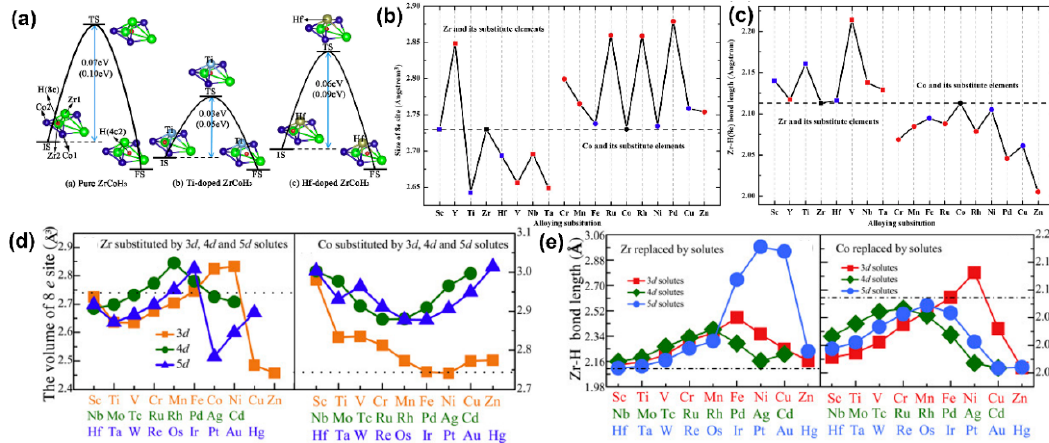
Figure 5. ( a ) Schematic diagram of H diffusion from the 8e site to the 4c 2 site in undoped, Ti-doped, and Hf-doped ZrCoH 3 ; ( b ) sizes of the 8e site in the undoped and doped ZrCoH 3 crystal; ( c ) the Zr–H (8e) bond length in the tetrahedron of undoped and doped ZrCoH 3 with the 8e site occupied by a H atom [60]; ( d ) volumes of the tetrahedron when one of the Zr / Co atoms in the tetrahedron is substituted by 3d, 4d, and 5d transition alloying solutes; ( e ) the bond lengths of Zr and H at the 8e site (at the center of the tetrahedron) when one of the Zr / Co atoms in the tetrahedron is substituted by 3d, 4d, and 5d transition alloying solutes [95].